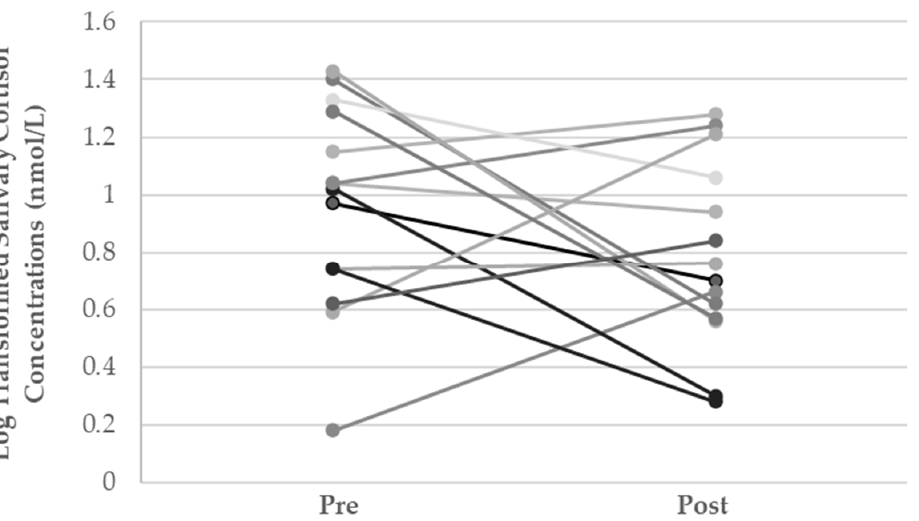
Figure A1. Plot showing changes in salivary cortisol concentrations pre- and post-participation in beaver harvesting activities for all participants.